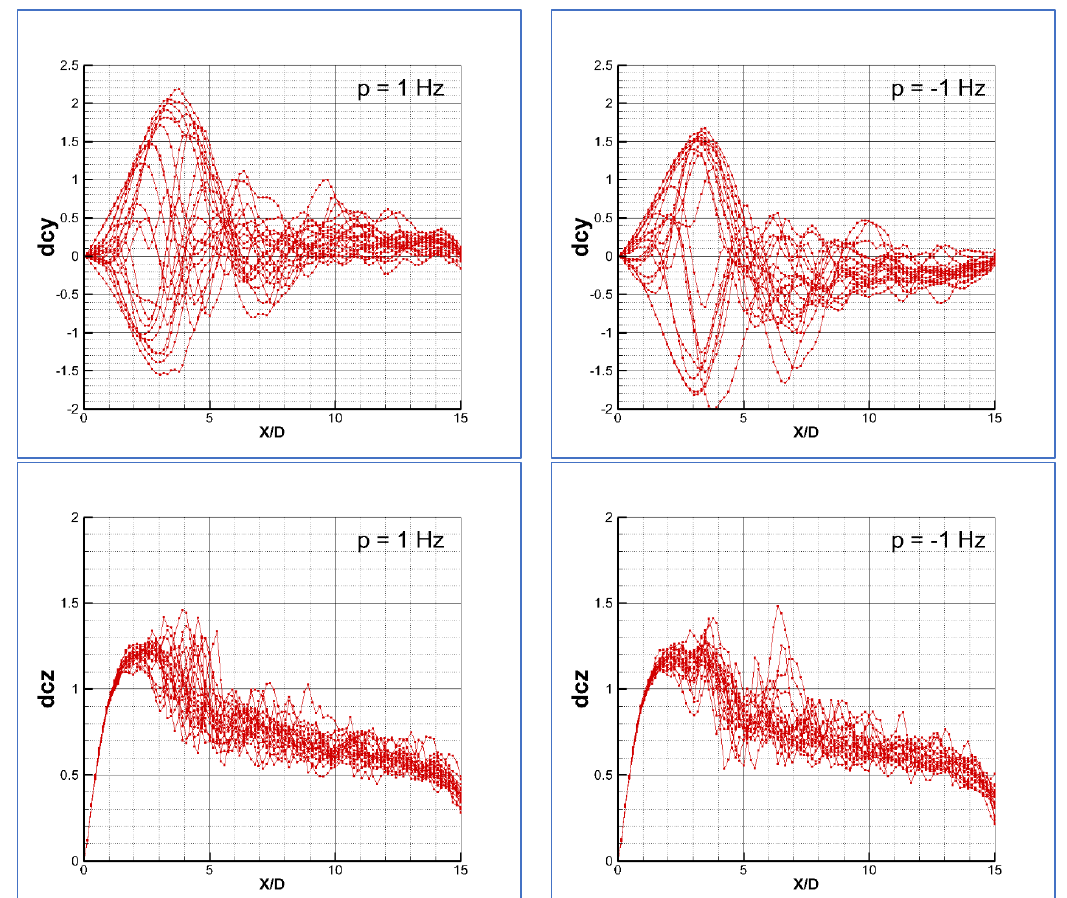
Figure 4. Local side force coefficient ( above ) and normal force coefficient ( below ). Last cycle ( T = 1 s, taken each ∆ t = 5 × 10 − 2 s. Ma = 0.2, Re =2 × 10 6 and α = 45 deg. Calculation with p = 1 Hz ( left ) and p = −1 Hz ( right ).